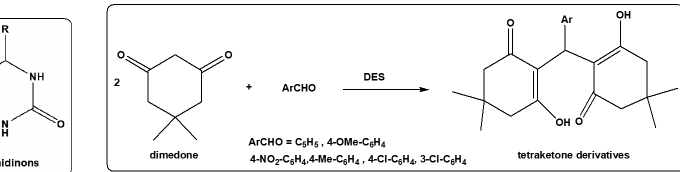
Figure 14: DES catalysed synthesis of tetraketone derivatives. j